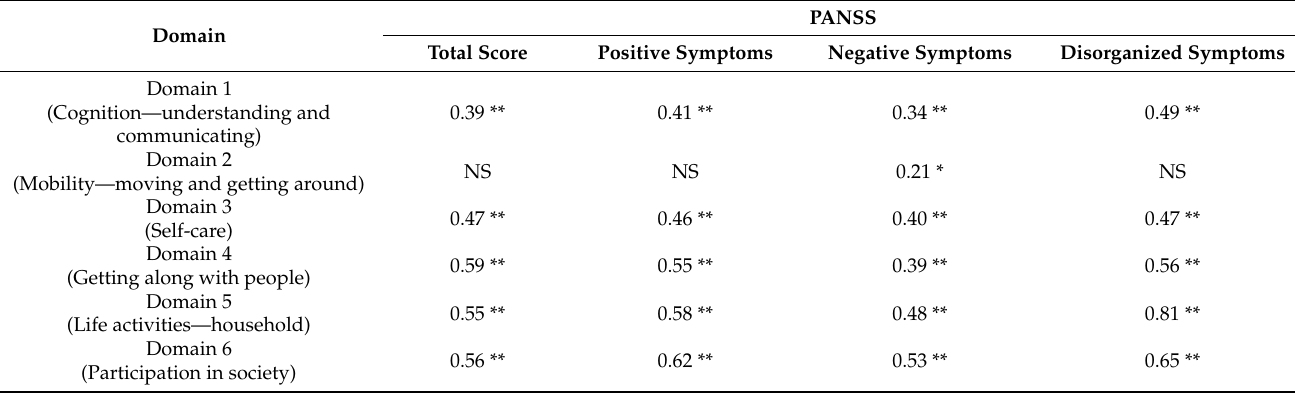
Table 2. Correlation with